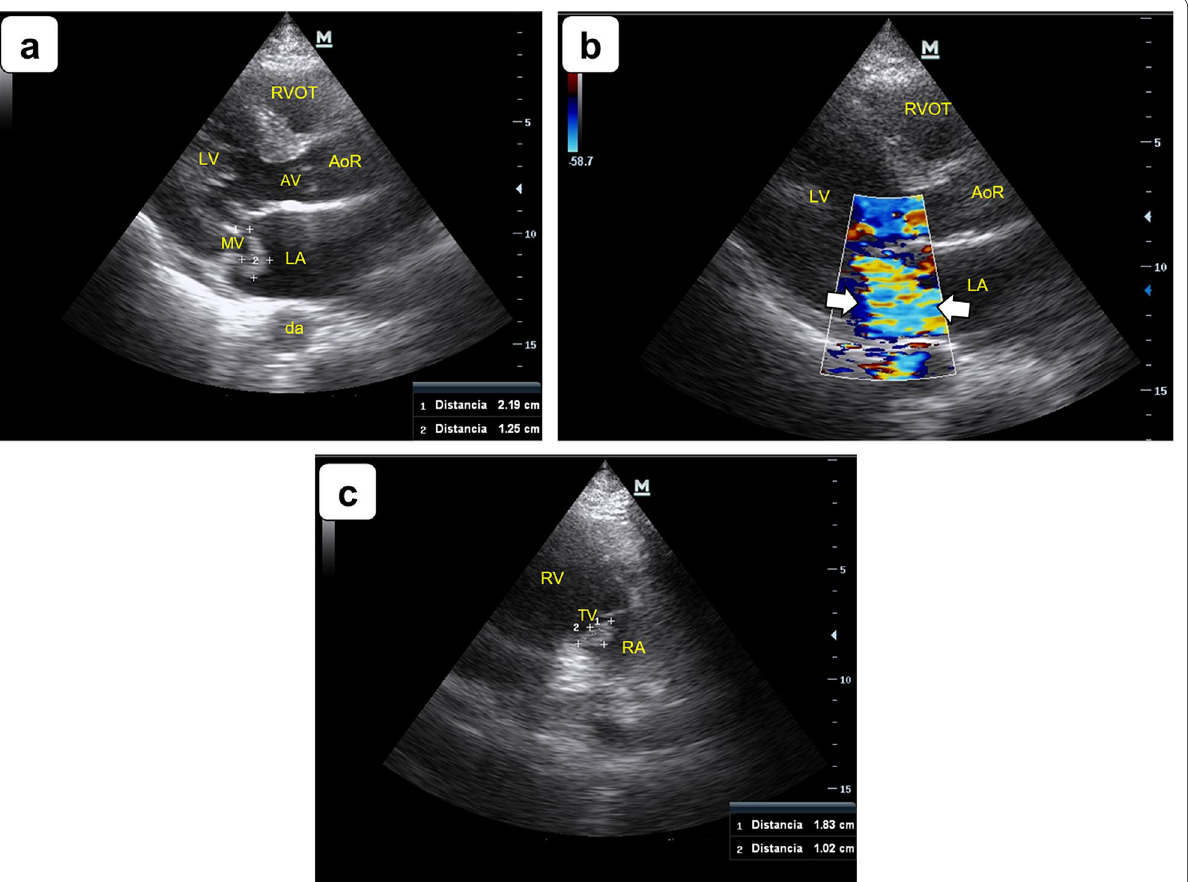
Fig. 1 Point-of-care transthoracic echocardiogram showing signs of infective endocarditis. a Parasternal long axis (PLAX) view depicting a vegetation measuring 22 mm 13 mm (calipers) attached to the atrial side of the anterior leaflet of the mitral valve. b PLAX showing a severe mitral × regurgitation (arrows) triggered by the mitral valve vegetation. c Right ventricular inflow view showing a vegetation of 18 mm in the atrial side of the posterior leaflet of the tricuspid valve. LV left ventricle, LA left atrium, AoR aortic root, AV aortic valve, MV mitral valve, da descending aorta, RVOT right ventricular outflow tract, RV right ventricle, RA right atrium, TV tricuspid